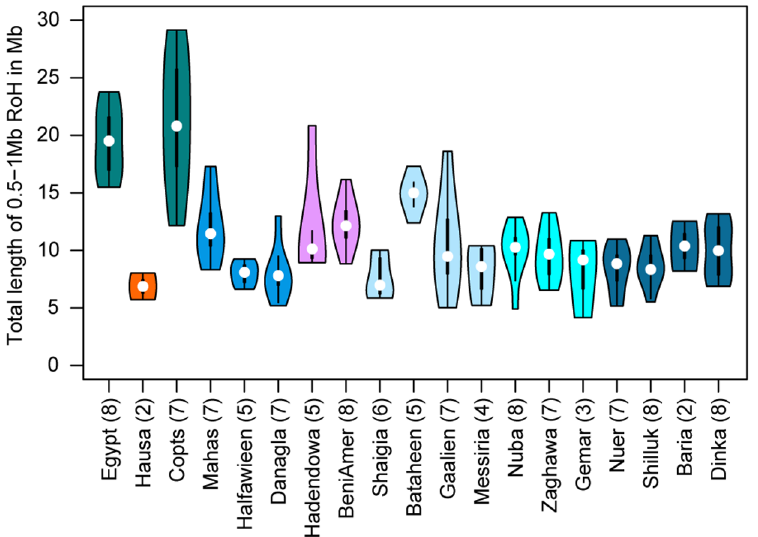
Fig 4. Distribution of total length of runs of homozygosity per individual per population. Runs of homozygosity are between0.5–1 Megabases(Mb) in length. Runs of homozygositywere calculatedon a chimeric dataset